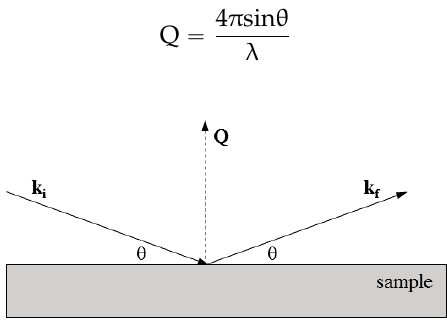
Figure 3. Schematic of reflectometry geometry.